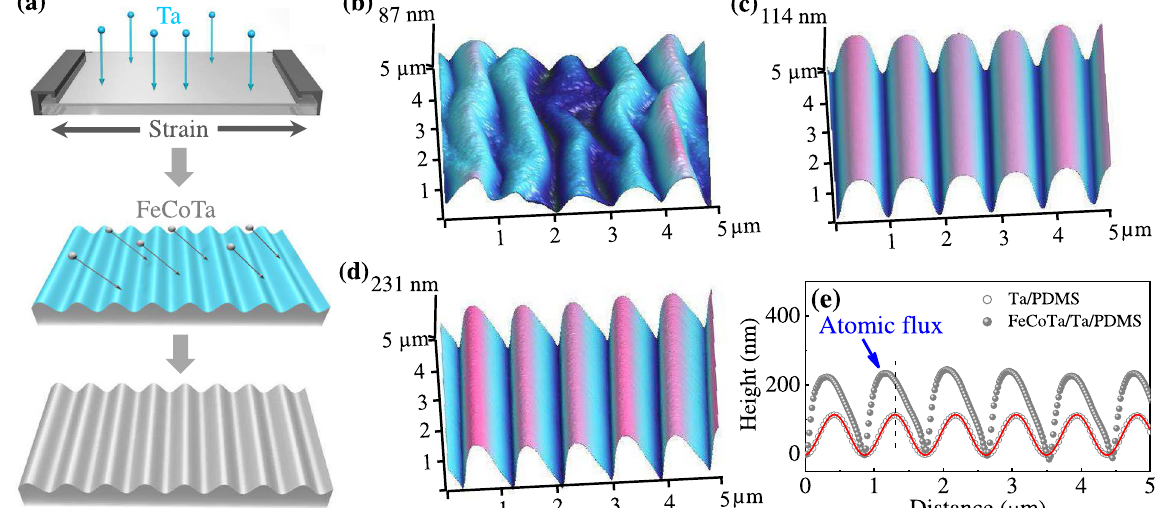
Figure 1. ( a ) Schematic plots for the steps of fabricating wrinkled magnetic FeCoTa films. ( b ) AFM image for a 150 nm FeCoTa film obliquely deposited at ϕ = 45° on a non-strained Ta(5 nm)/PDMS. ( c ) AFM image for a 5 nm Ta layer grown on a pre-strained 20% PDMS. (d) AFM image for a 150 nm FeCoTa film obliquely deposited at ϕ = 45° on the wrinkled topography of ( c ). ( e ) The cross-sectional views extracted from both Ta/ PDMS (gray circle) in ( c ) and FeCoTa/Ta/PDMS (gray sphere) in ( d ). The red line is the sinusoidal fitting for the cross-sectional view of